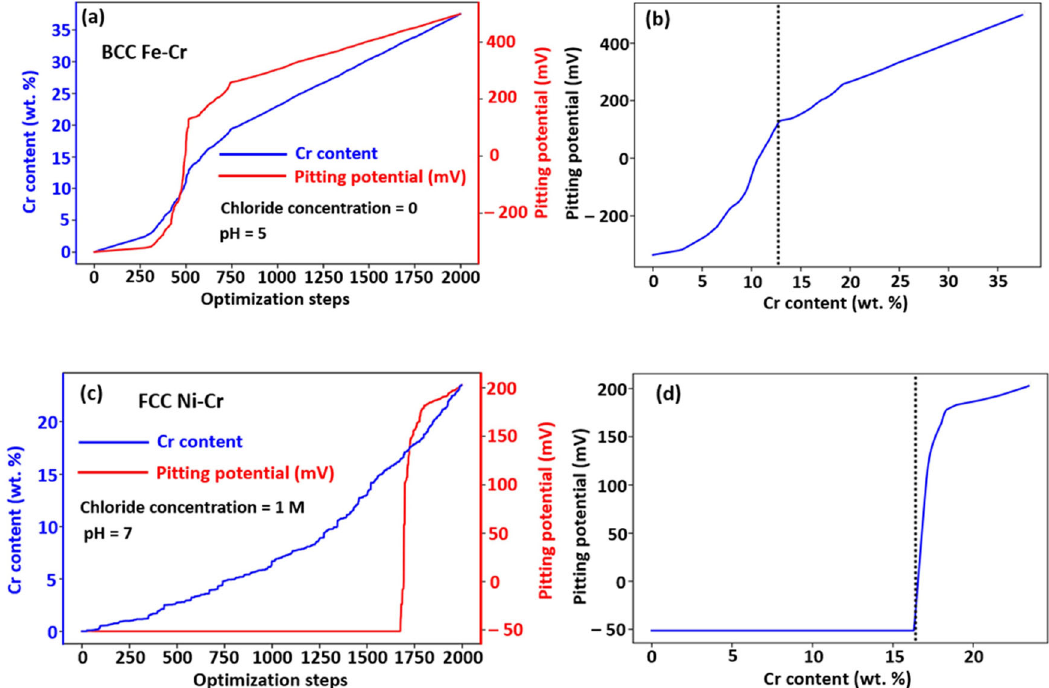
Fig. 5 Optimizations allowing variation of Cr content alone. Variation of Cr content and pitting potential during optimization history have been plotted. Initial compositions are a pure Fe c pure Ni. The pitting potential predicted by the trained network as a function of Cr content is plotted for b BCC Fe-Cr alloys and d FCC Ni-Cr alloys. The active-passive transitions at the respective critical Cr contents in both the alloy systems can be seen to have been successfully predicted by the trained